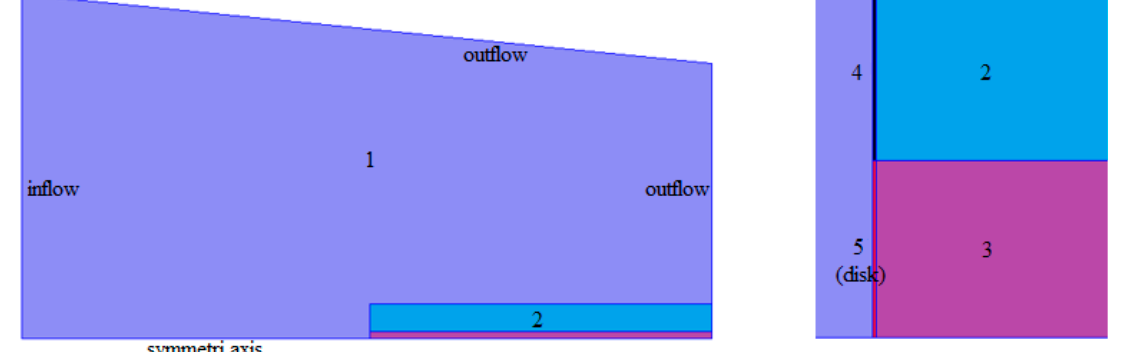
− 0.098 Figure A1. Relative difference in 𝐶 (cid:3043) distribution for different discretizations.